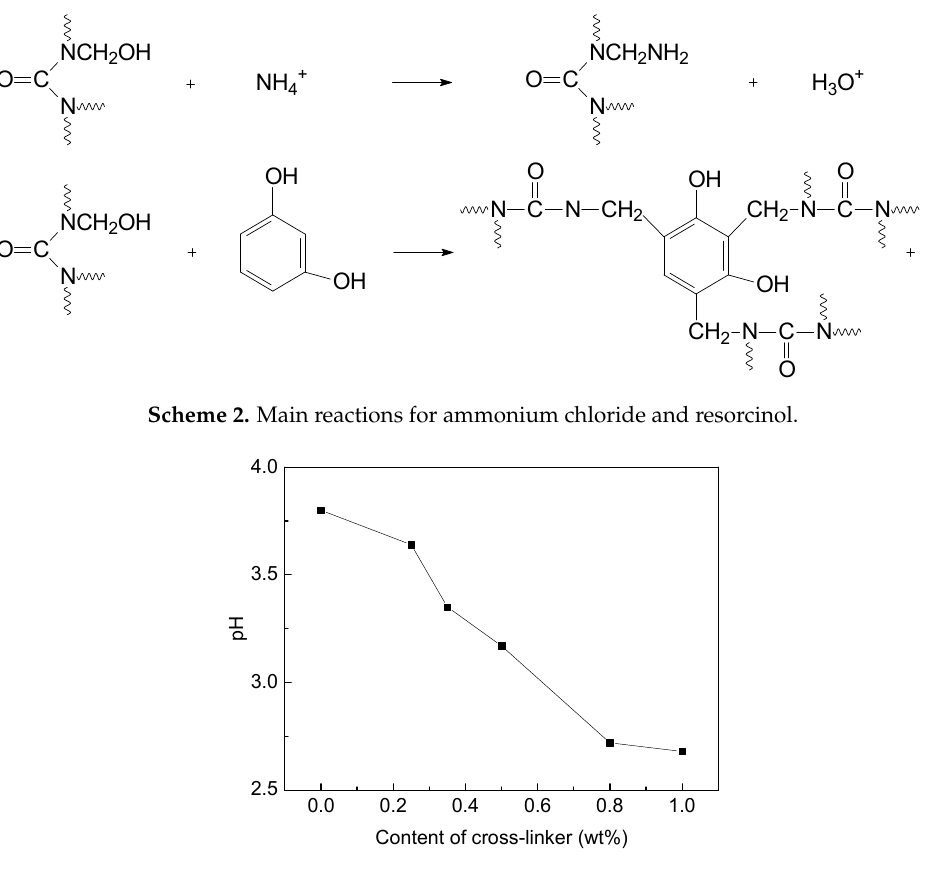
Figure 10. Dependence of reaction system pH value on the addition of crosslinker.